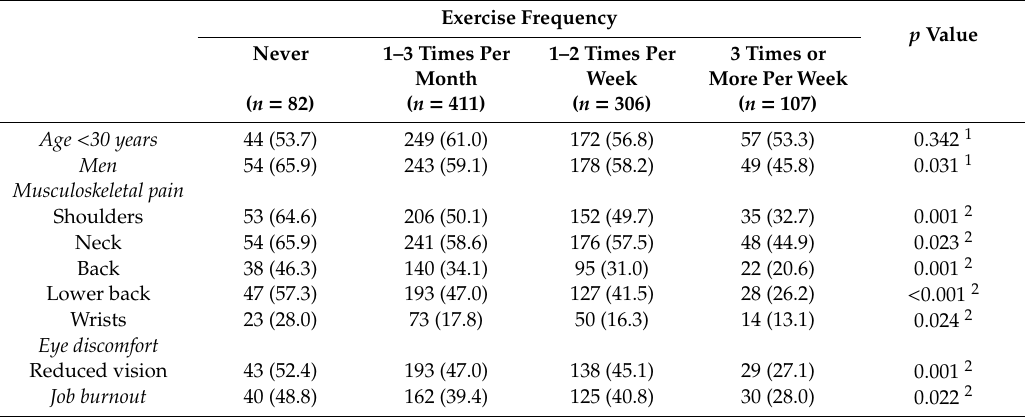
Table 3. Number of participants (%) with demographic or health conditions among di ff erent exercise